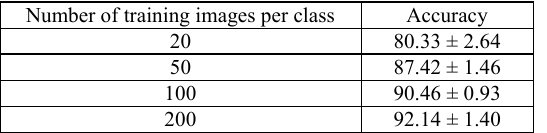
Table 1. Classification accuracies (%) using VLAD image representation and SVM classifier obtained using training sets of different